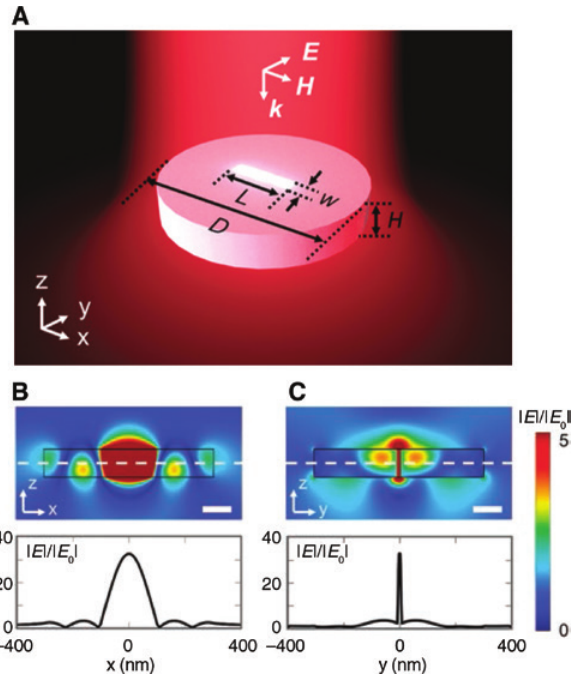
Figure 3: Anapole in a slotted nanodisk for enhanced light